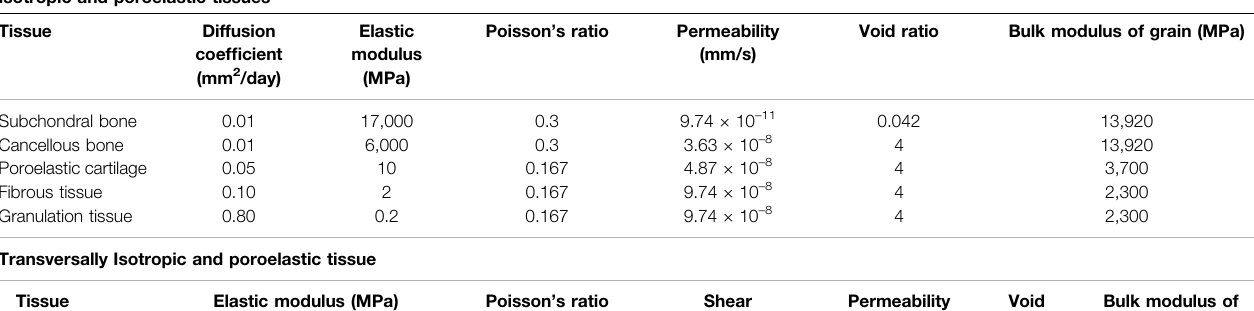
TABLE3| Propertiesofbiologicaltissues(Kelly&Prendergast,2005;Chenetal.,2011;Tortoricietal.,2021).Allporoelastictissueshadaspeci fi cweightofthewettingliquid of 9.74 × 10 – 6 N/mm 3 and a bulk modulus of fl uid of 2,300 MPa. The axial, radial, and circumferential directions are indicated by 1, 2, and 3, respectively. E : elastic modulus; ] : Poisson ’ s ratio; G : shear modulus. Isotropic and poroelastic tissues